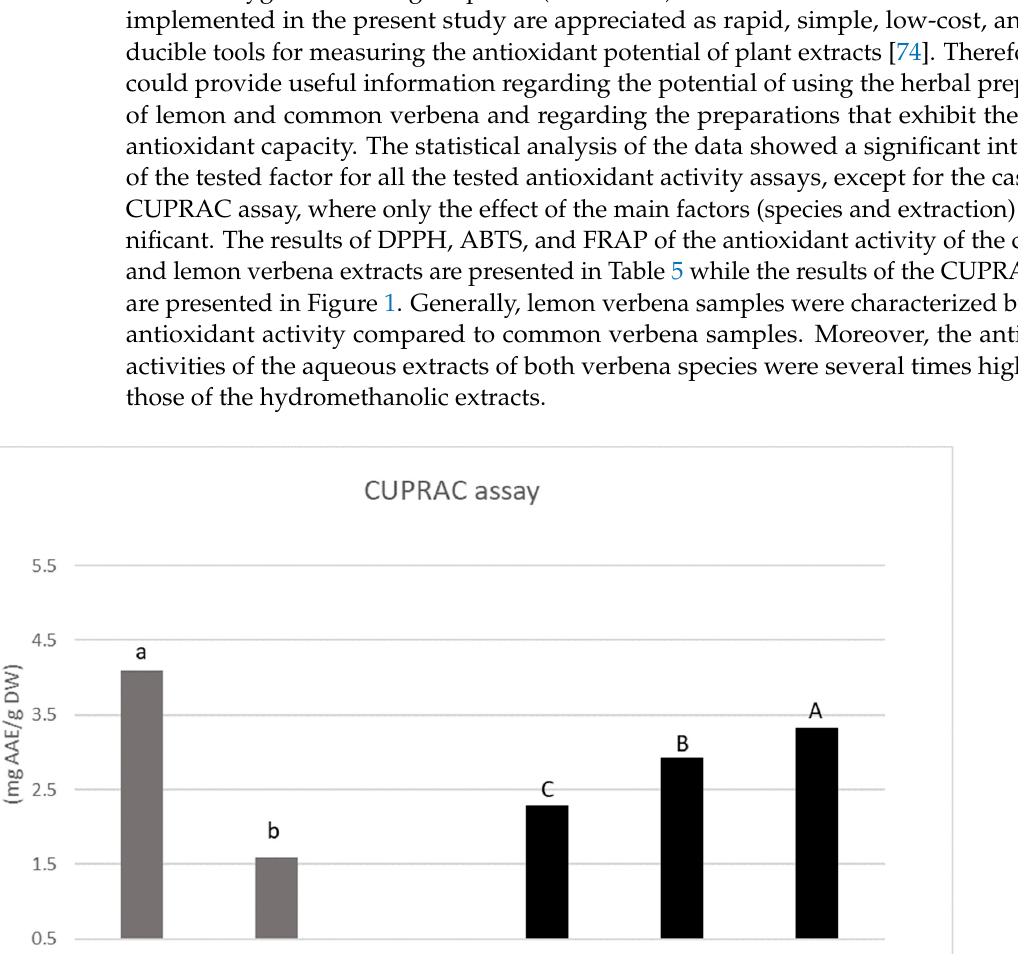
Table 5. Antioxidant activity of the hydromethanolic extract, infusion, and decoction of Verbena of- ficinalis and Aloysia citrodora .